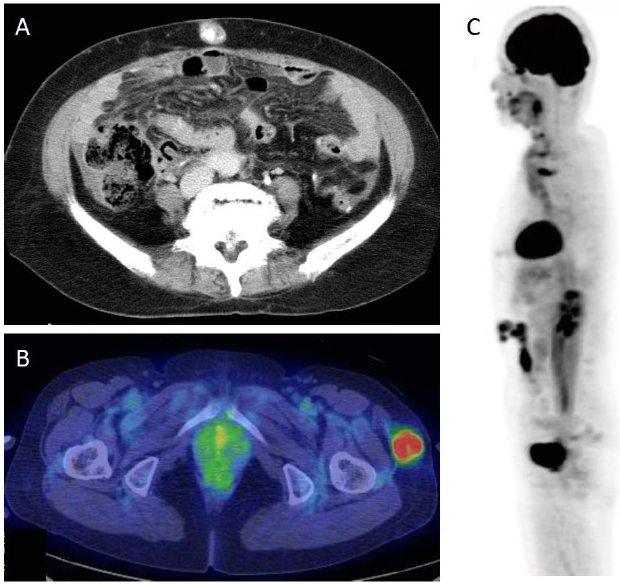
Figure 1. ( A ) CT scan of umbilical metastasis, a Sister Joseph nodule (SJN). ( B ) PET/CT scan of a non-SJN metastasis. ( C ) 18 F-fluorodeoxyglucose (FDG)-PET image of skin recurrence in surgical scar. FDG uptake is seen in the abdominal surgical scar.